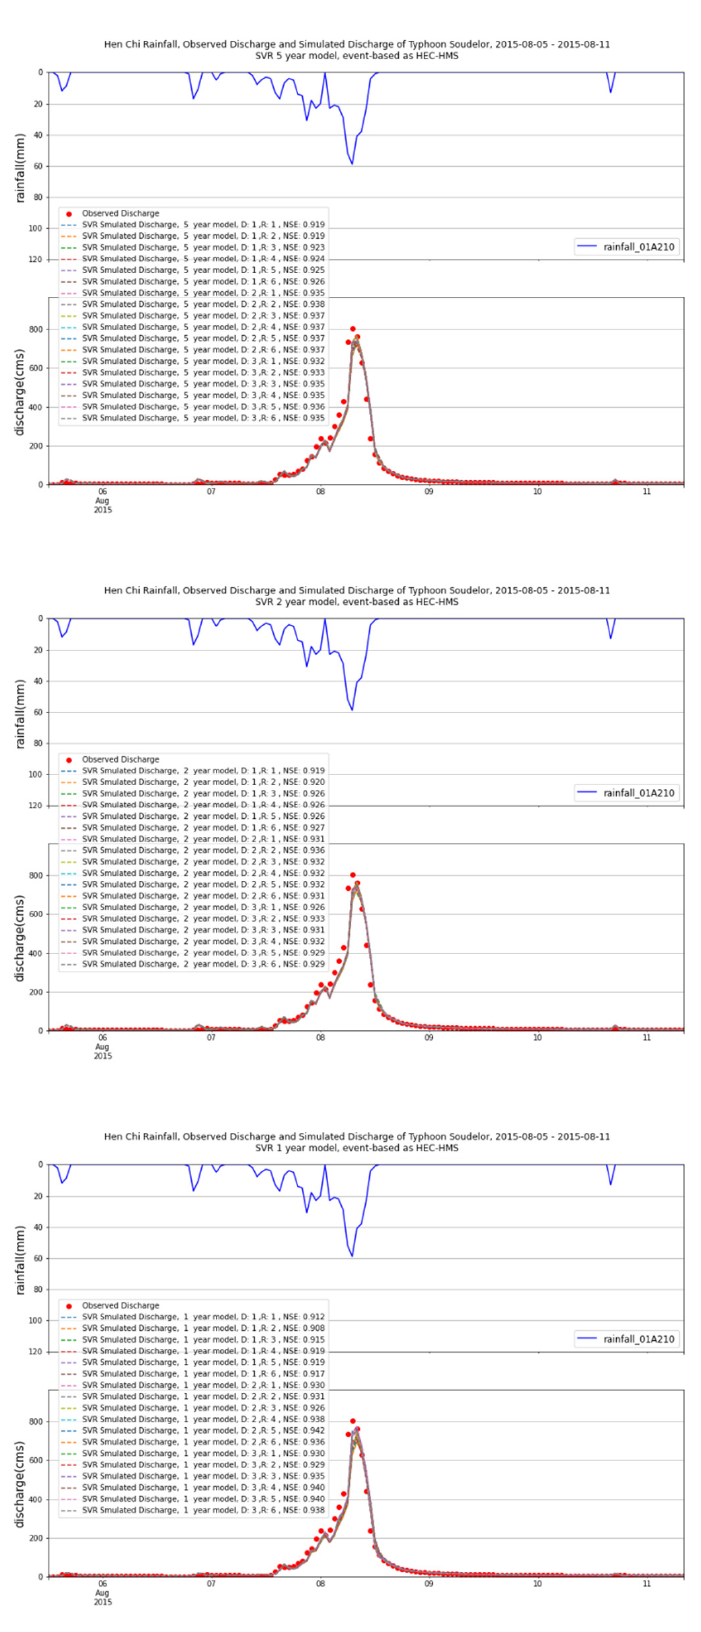
Figure 9. The testing results derived from the Type 2 SVR model using different features selection for Typhoon Soudelor. D 1 to 3 represents discharge features of the previous 1 to 3 h, while R 1 to 6 indicates rainfall features of the previous 1 to 6 h.